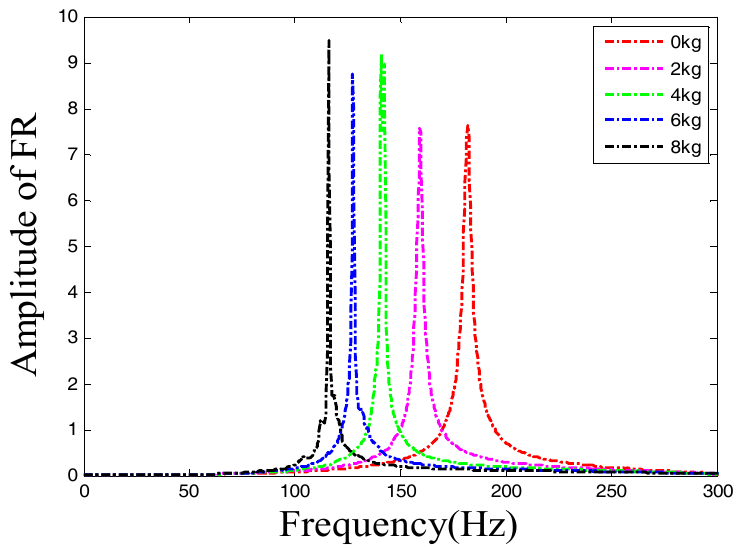
Figure 9. Changes of the first frequency with different masses (VDM).